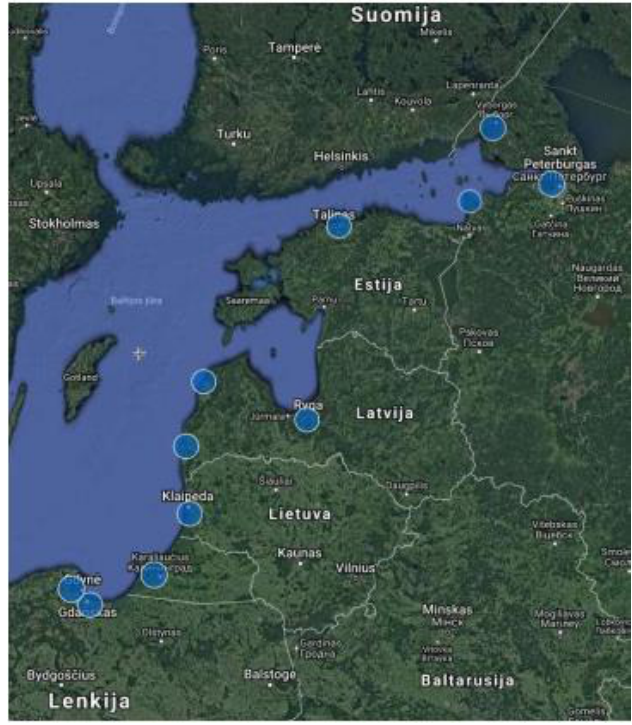
Figure 2. Key ports of the eastern Baltic Sea coast. Source: [62].